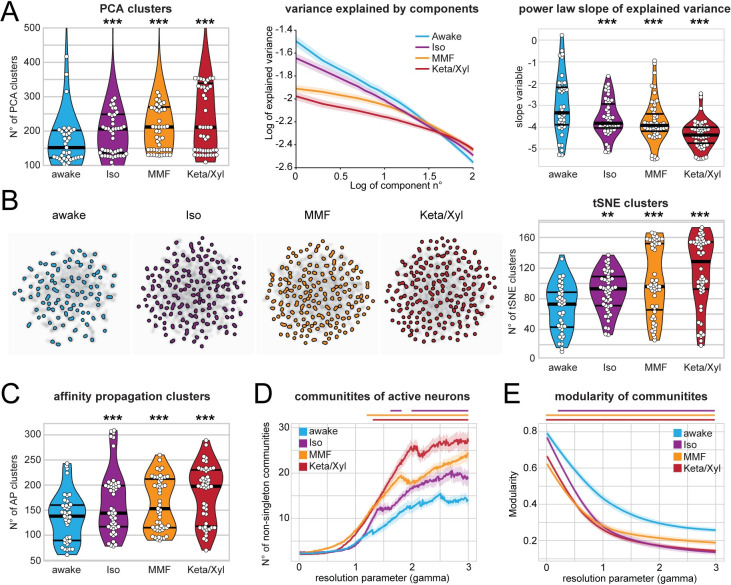
Calcium activity in CA1 is temporally and spatially fragmented during anesthesia.(A) Left: violin plot quantifying the number of PCA clusters during wakefulness or anesthesia, as indicated. Middle: log-log line plot displaying the variance explained by the first 100 components for each condition. Right: violin plot quantifying the power-law slope of the variance explained by the first 100 components for each condition. (B) Left: tSNE plots of network events recorded in the same animal under the 4 indicated conditions. Right: Violin plot quantifying the number of tSNE clusters obtained from calcium recordings during the 4 different treatments. (C) Violin plot quantifying the number of clusters obtained by AP from calcium recordings during the 4 different treatments. (D) and (E) Line plots quantifying the number of detected communities and the modularity of the detected communities with the resolution parameter gamma ranging from 0 to 3. Horizontal lines in violin plots indicate median and first to third quartile. Asterisks in (A)–(C) indicate significant differences to wakefulness. ** p < 0.01, *** p < 0.001. Horizontal lines above plots in (D) and (E) indicate significant difference to wakefulness. Anesthetic conditions are color coded. Note, only differences to wakefulness are indicated. For comparison between conditions, see S1 Table. All datasets of this figure can be found under https://github.com/mchini/Yang_Chini_et_al/tree/master/Stats_Dataset_(R)/datasets/Figure6_S8. AP, affinity propagation; Iso, isoflurane; Keta/Xyl, ketamine/xylazine; MMF, medetomidine/midazolam/fentanyl; PCA, principal component analysis; tSNE, t-distributed stochastic neighbor embedding.